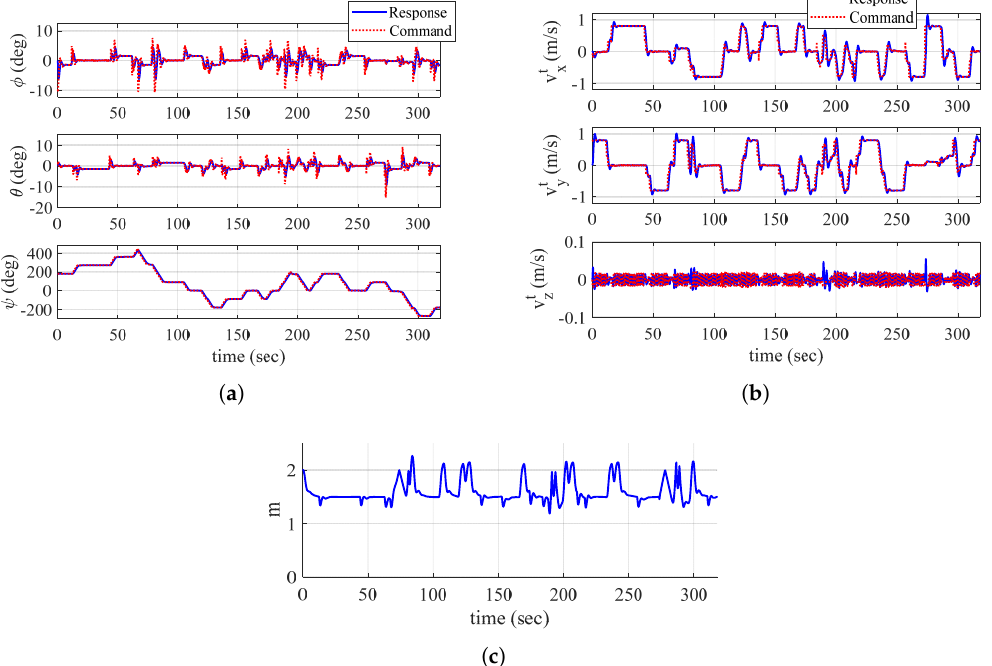
Figure 11. Time histories of UAV-related parameters (Simulation III): ( a ) attitude; ( b ) velocity (tangent–plane coordinate system); and ( c ) minimum distance between UAV and